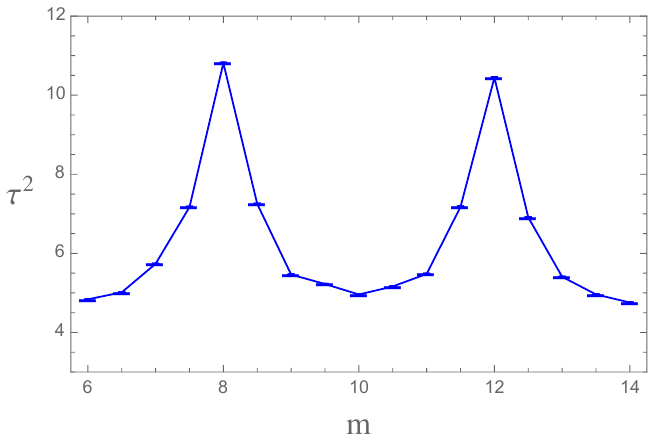
Figure 7 . The measure of second order curvature invariants (cid:28) 2 , as a function of m for the one parameter family of quintics in P 4 (3.2)